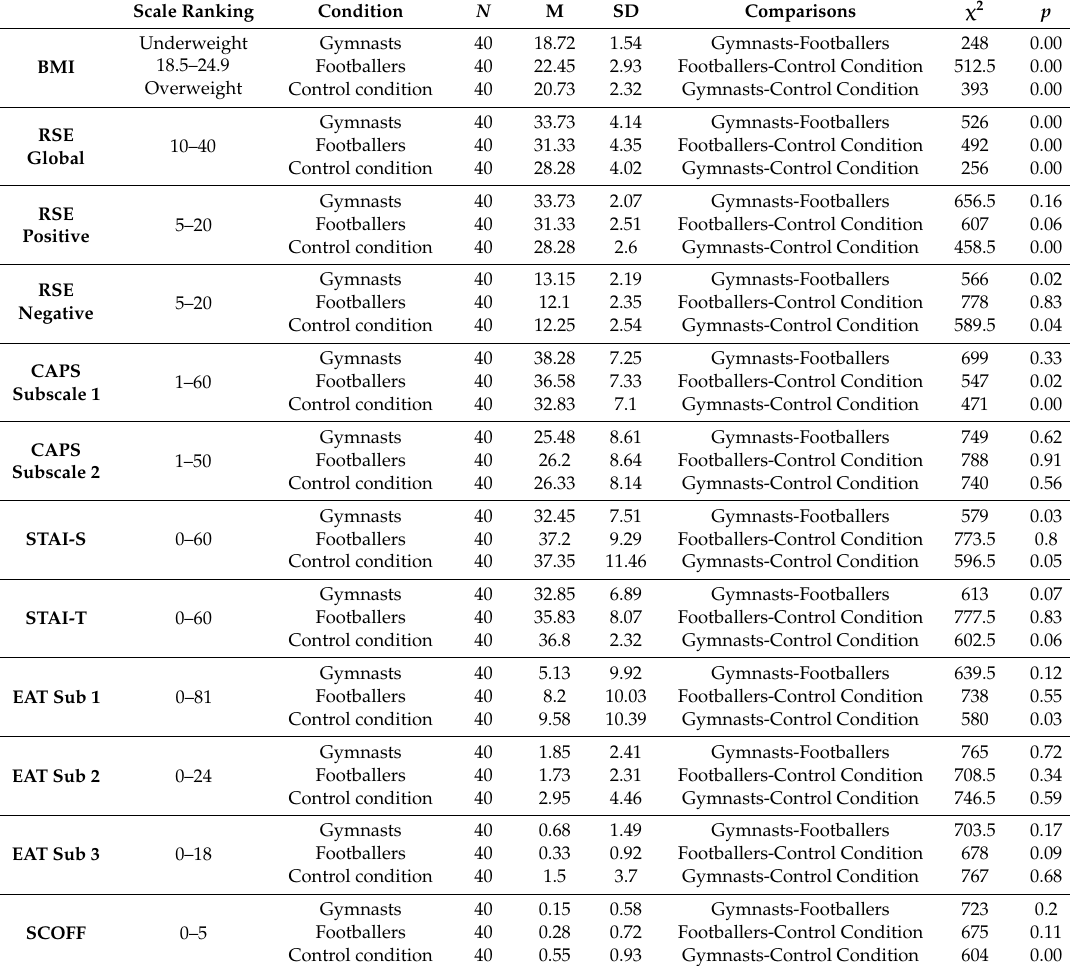
Table 5. Mann–Whitney test between the three conditions (Gymnasts, Footballers and Control